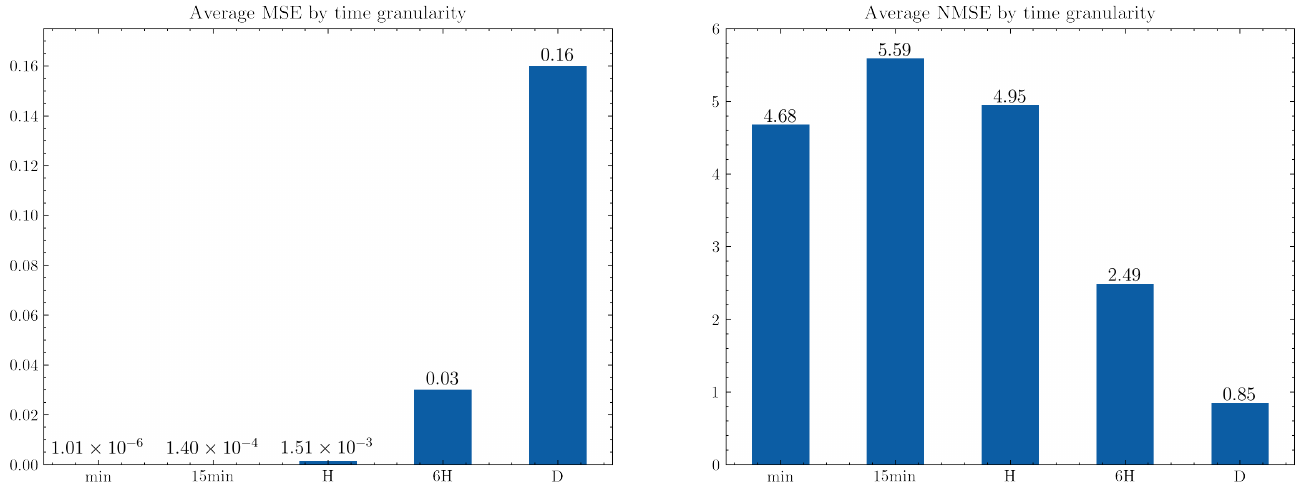
Figure 11. Average MSE and NMSE for 1 min, 15 min, 1 h, 6 h, and 1 day time period